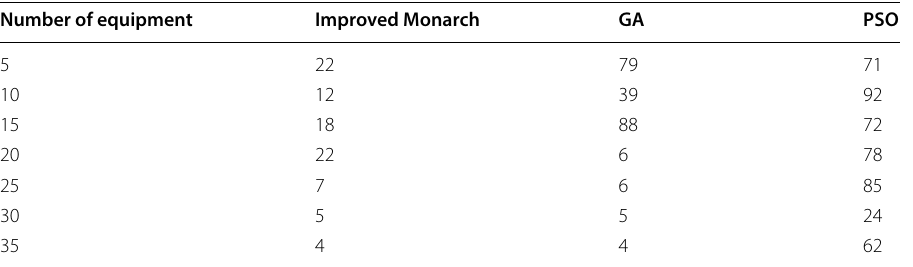
Fig. 11 Average income transformation of the network, when T changes